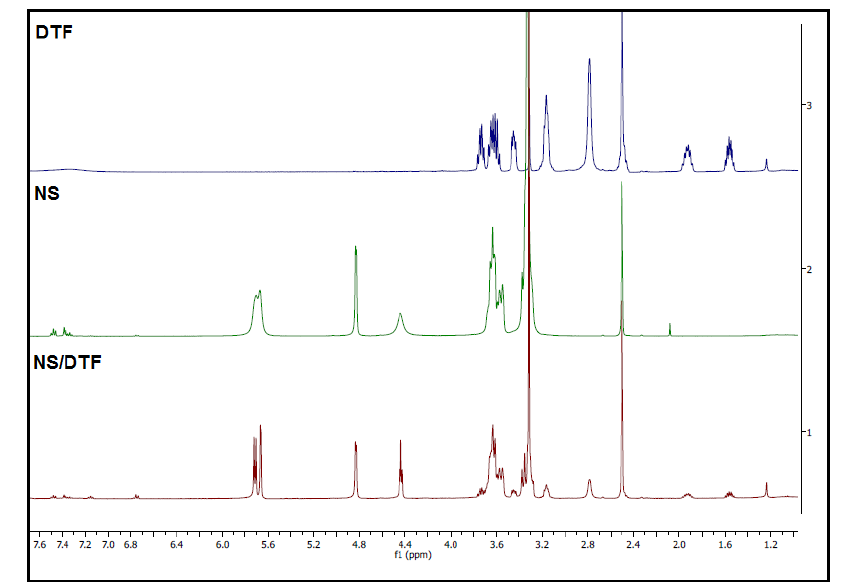
Figure 3. 1 H-NMR spectra (400 MHz, DMSO-d 6 ) of DTF, NS and the NS–DTF complex.